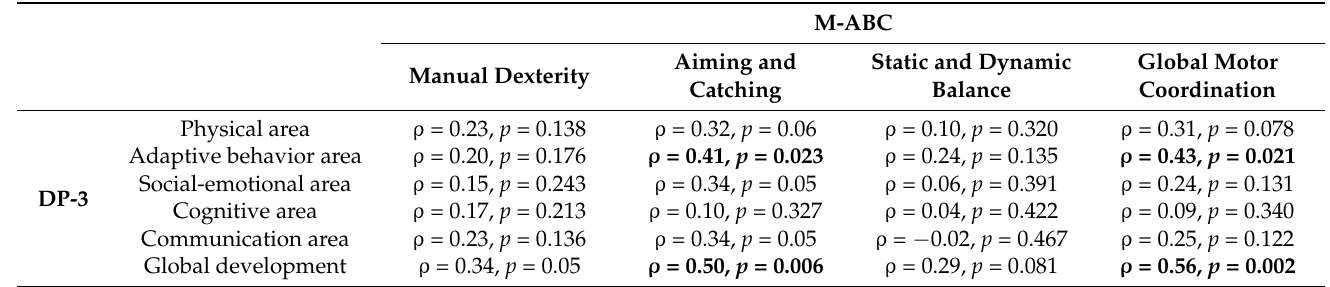
Table 3. Correlation analysis among the M-ABC and the DP-3 variables through Spearman’s correla- tion coefficient.